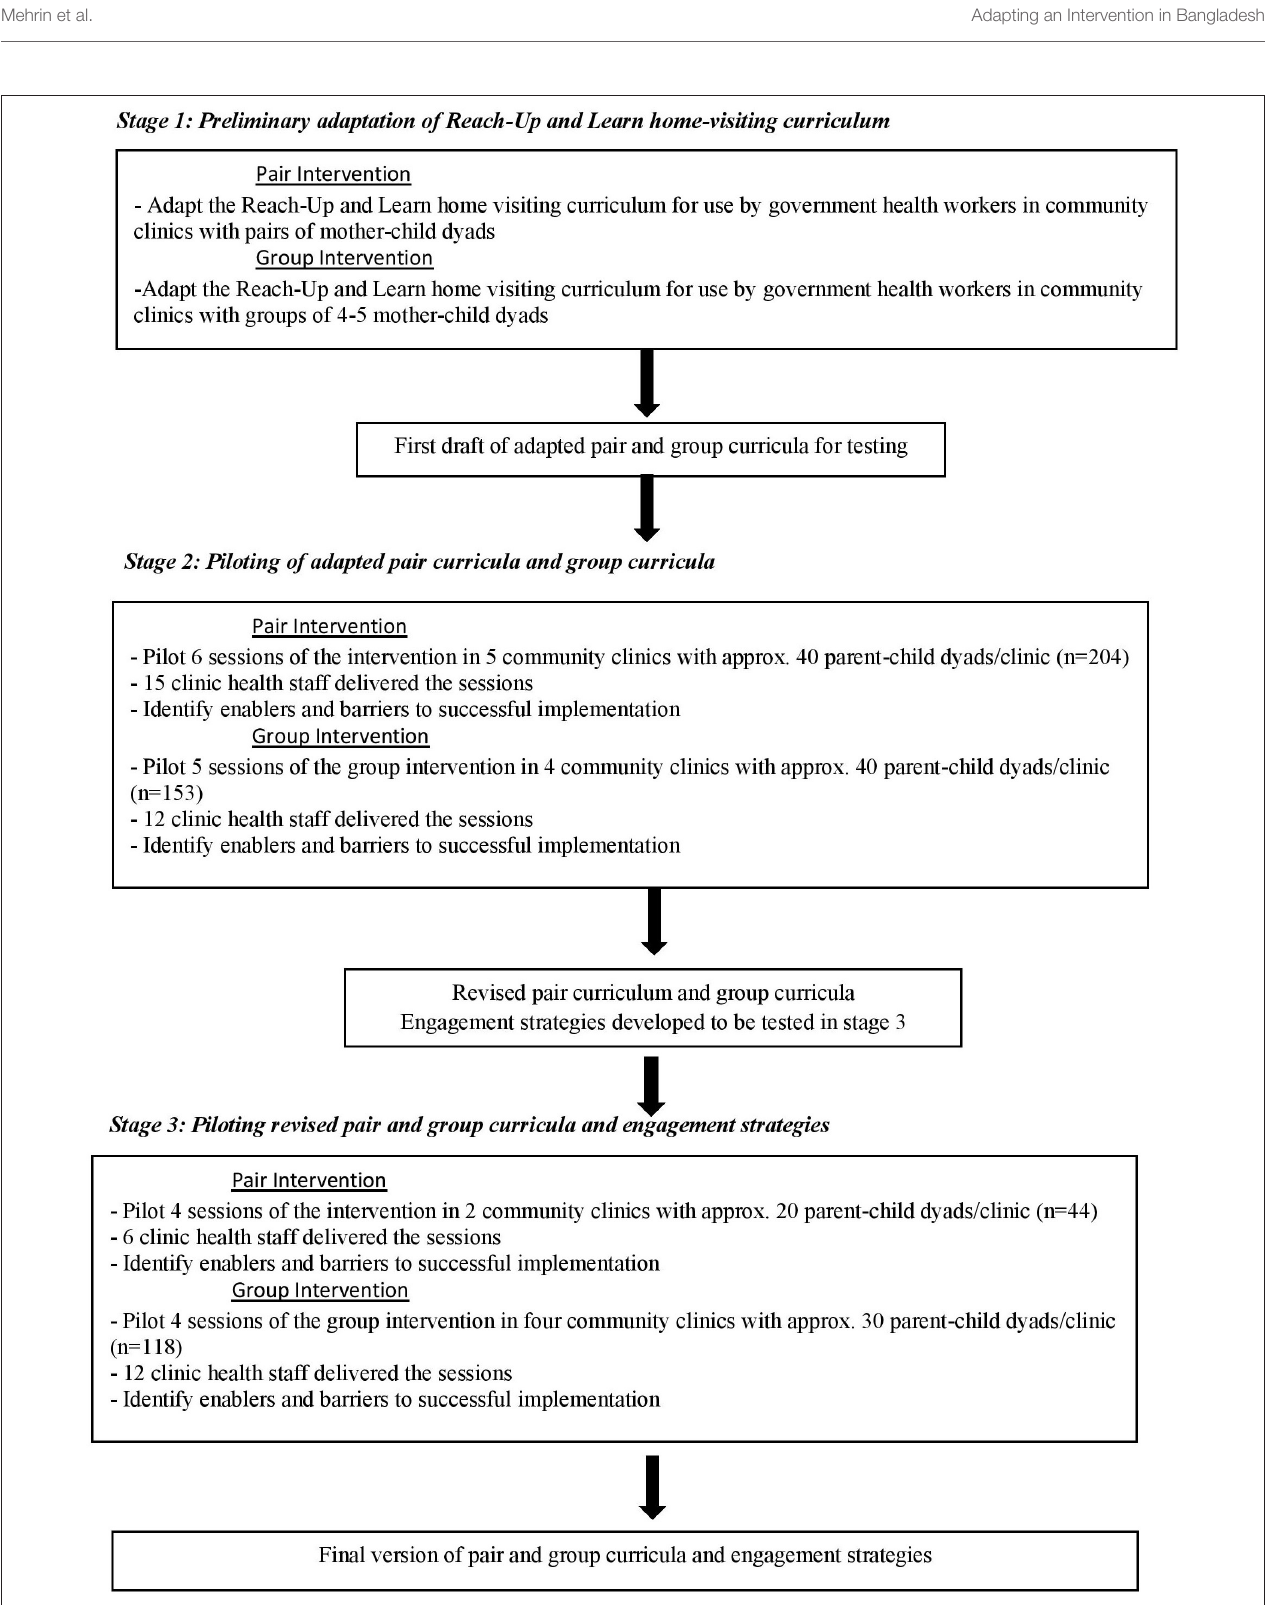
FIGURE 1 | Stages followed in adapting Reach Up and Learn for integration into Government Health Services in Rural Bangladesh.